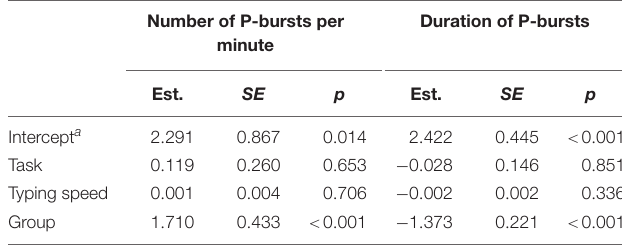
TABLE 9 | Estimates of fixed effects for effects of task, typing speed and group on number of P-bursts per minute and duration of P-bursts. Number of P-bursts per minute